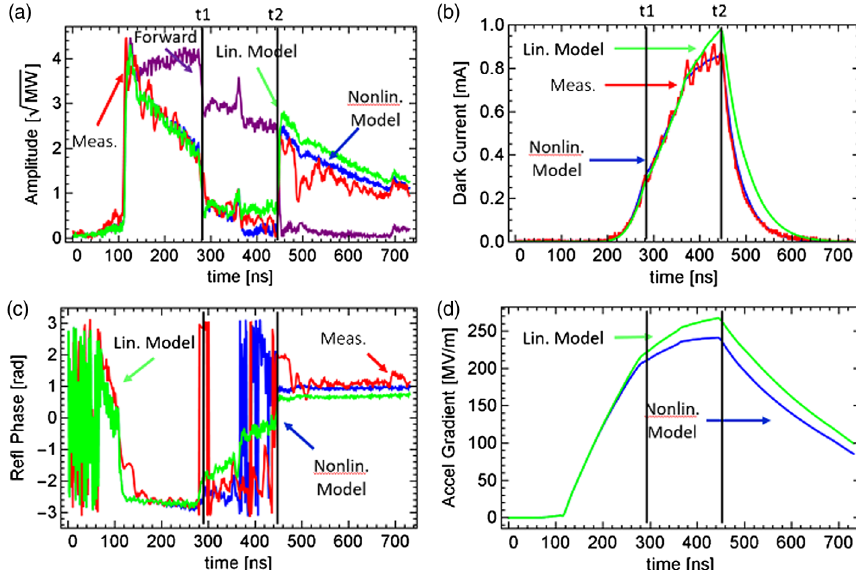
FIG. 6. Measured and reconstructed rf and current monitor signals for an example rf pulse. The measured current will be a small percentage of the field emitted current inside the cavity, which we estimated to be on the order of .1 – 1% [70]. Measured signals are in purple and red. Results of the nonlinear model are in blue and results from a linear model are in green. t 1 and t 2 are defined as the section where the input rf power is decreased to a lower power level and the gradient is flat, which for this pulse is 150 ns